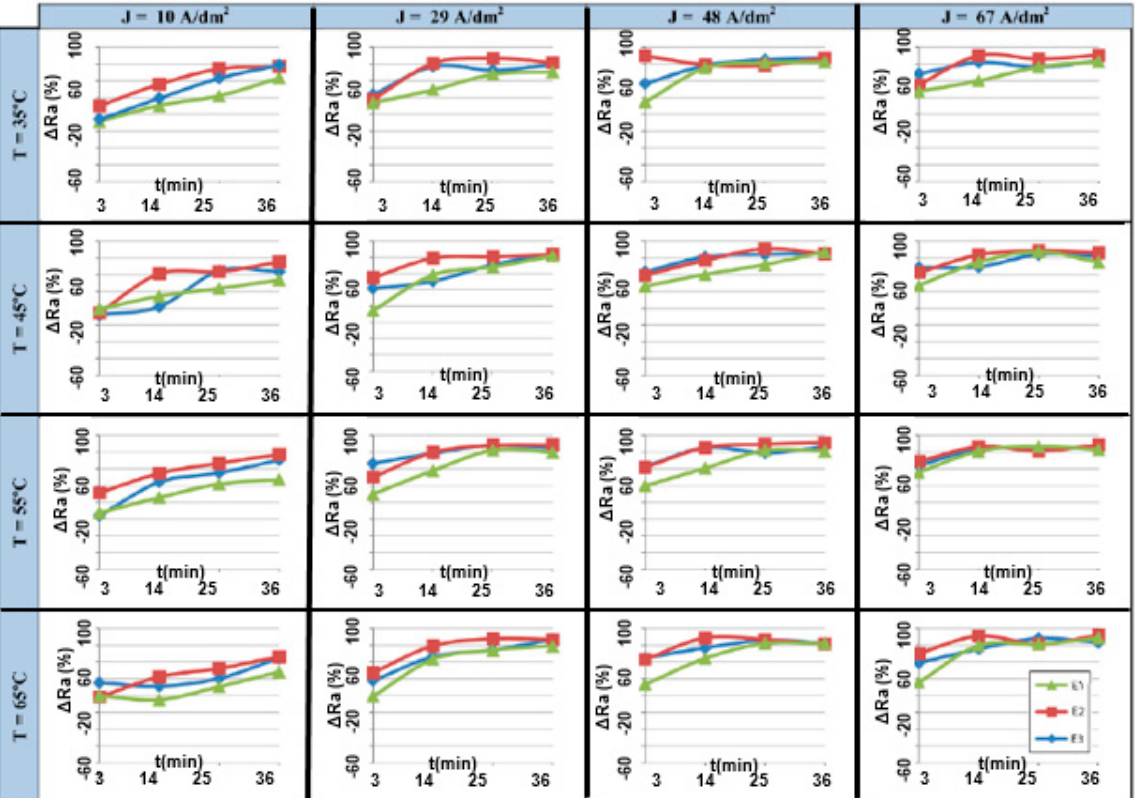
Figure 18. Influence of electrolyte, temperature, and current density of electropolishing of SS [20]; copyright granted by Elsevier.